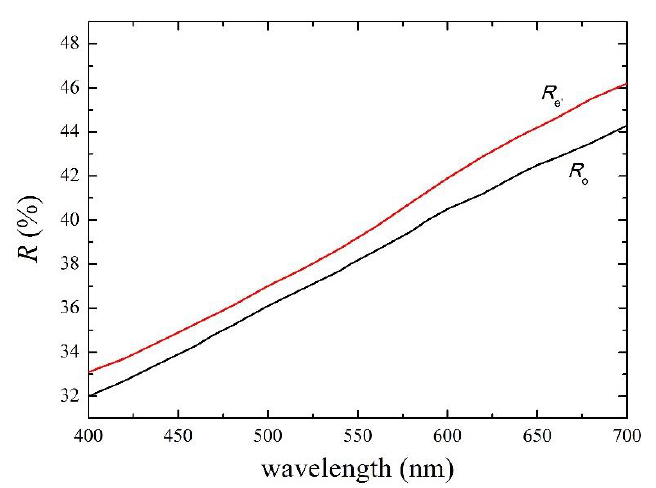
Figure 3. Reflectance data for eliopoulosite.